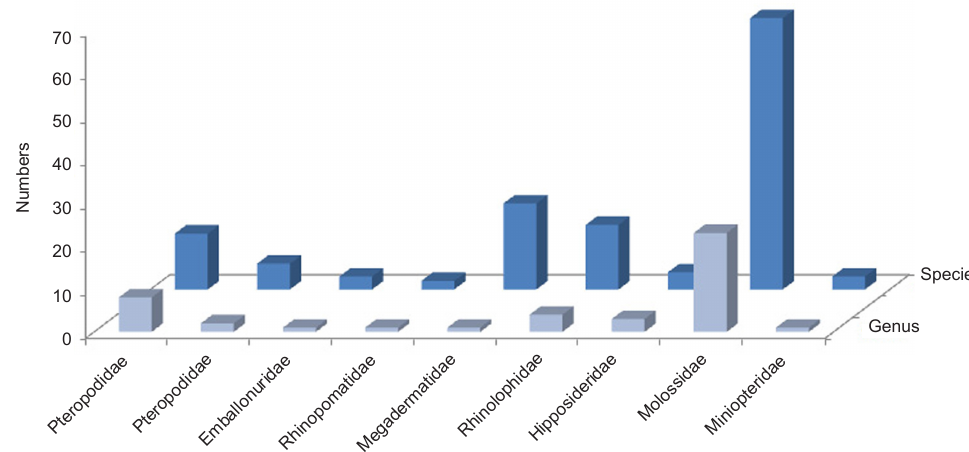
Figure 1. Chiropteran diversity in South asia